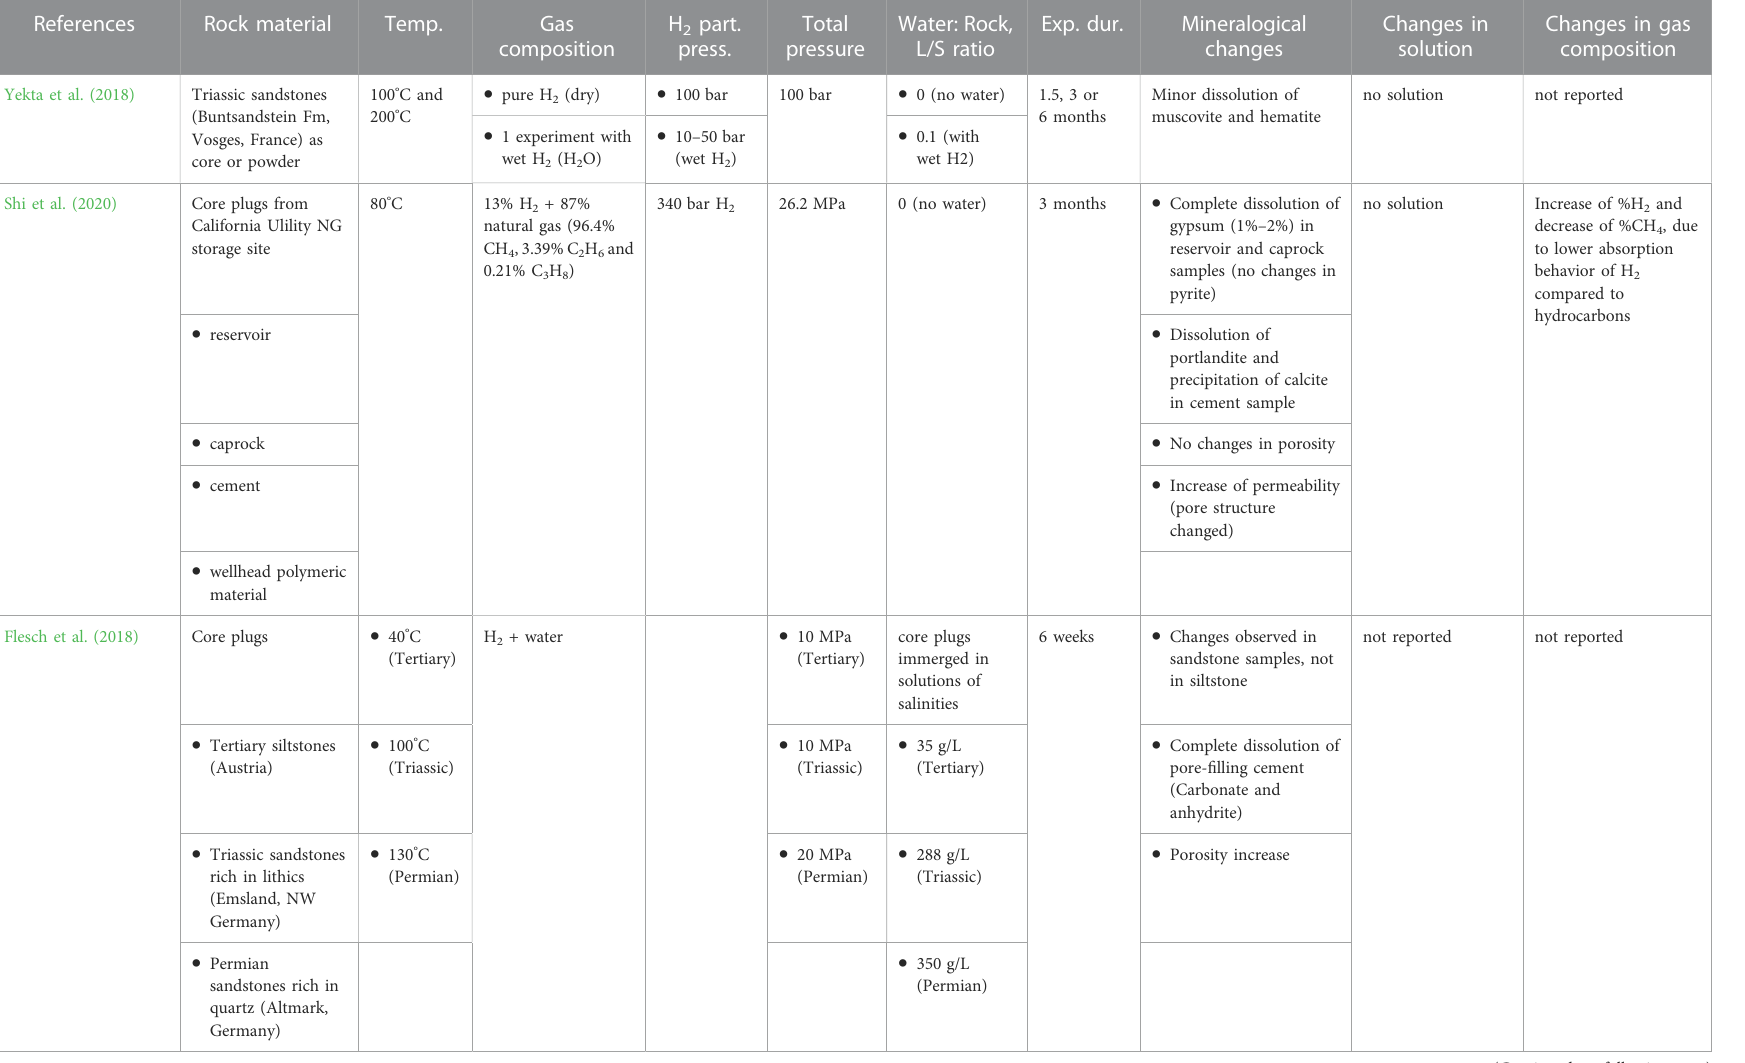
TABLE 2 Review of studies on the reactivity of hydrogen with rocks under conditions relevant for underground hydrogen storage in sandstone